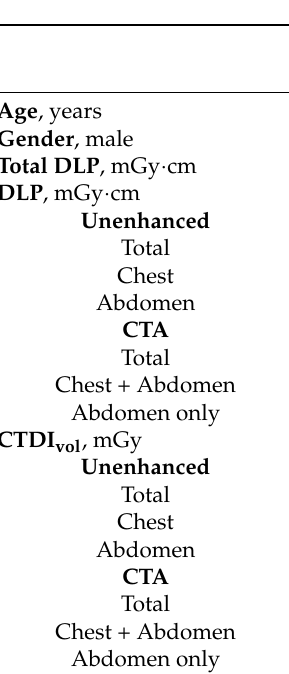
Table 1. Patient Characteristics and Dose